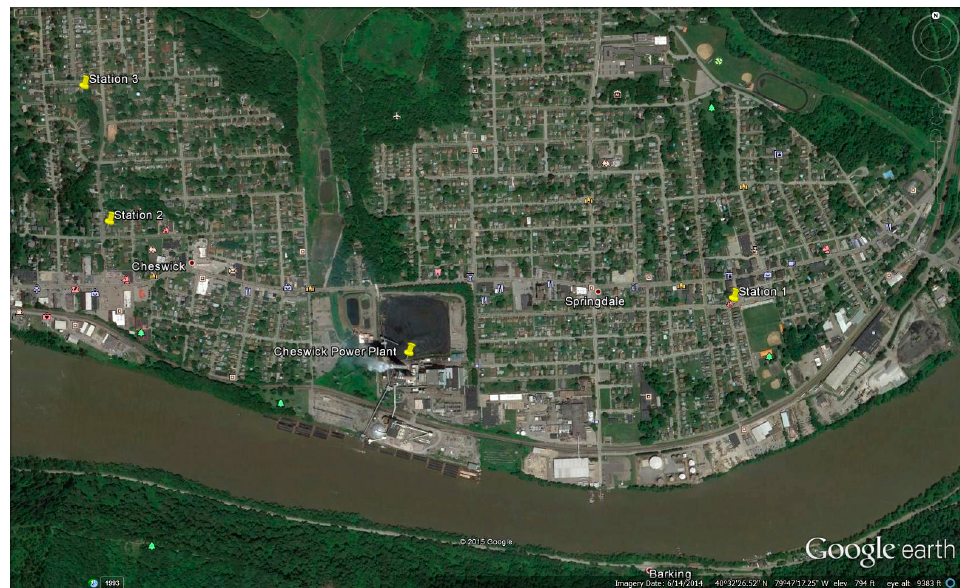
Figure 1. Location of monitoring stations in relation to the Cheswick Power Plant and the two boroughs of Springdale and Cheswick.